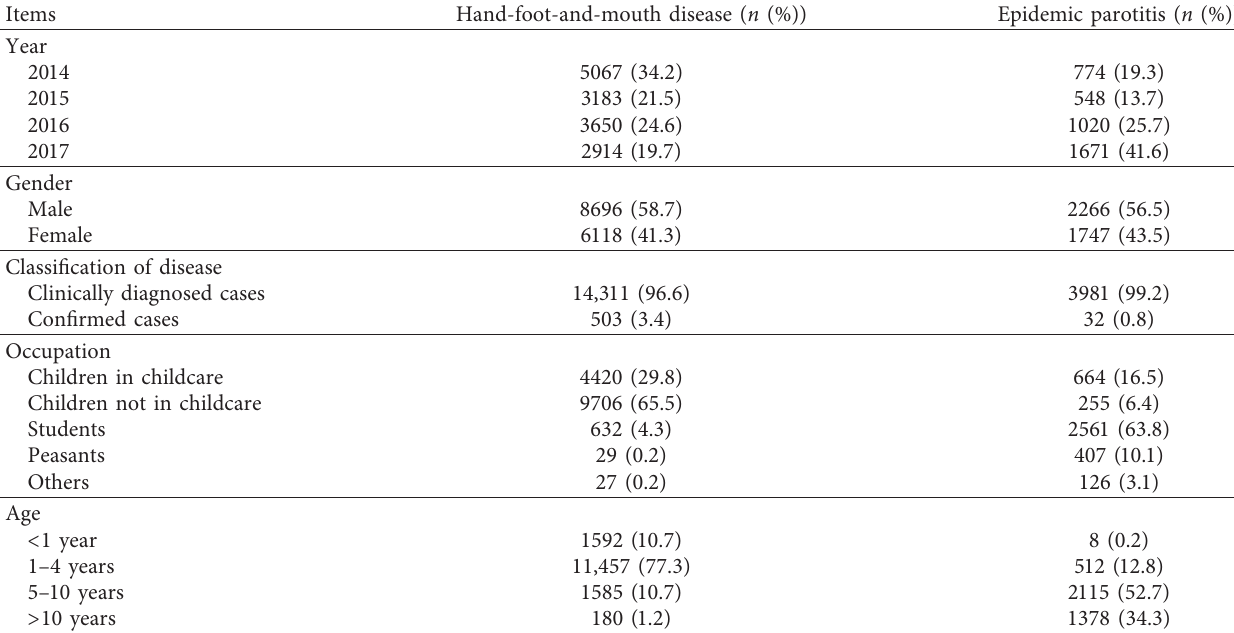
Table 1: Background information of patients with hand-foot-and-mouth disease or epidemic